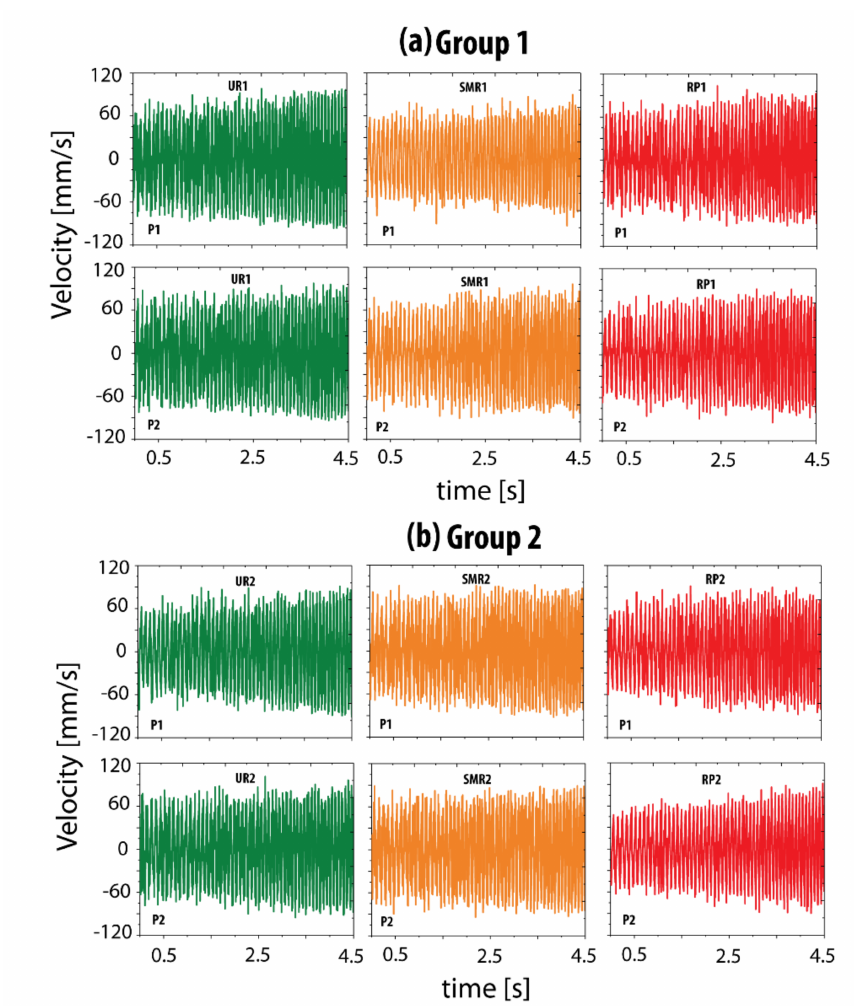
Figure 5. Time domain results of velocity between 10 and 100 Hz in e 1 and e 2 . P1 and P2 measure- ments for each sample. ( a ) Group 1 (UR1, SMR1, and RP1). ( b ) Group 2 (UR2, SMR2, and